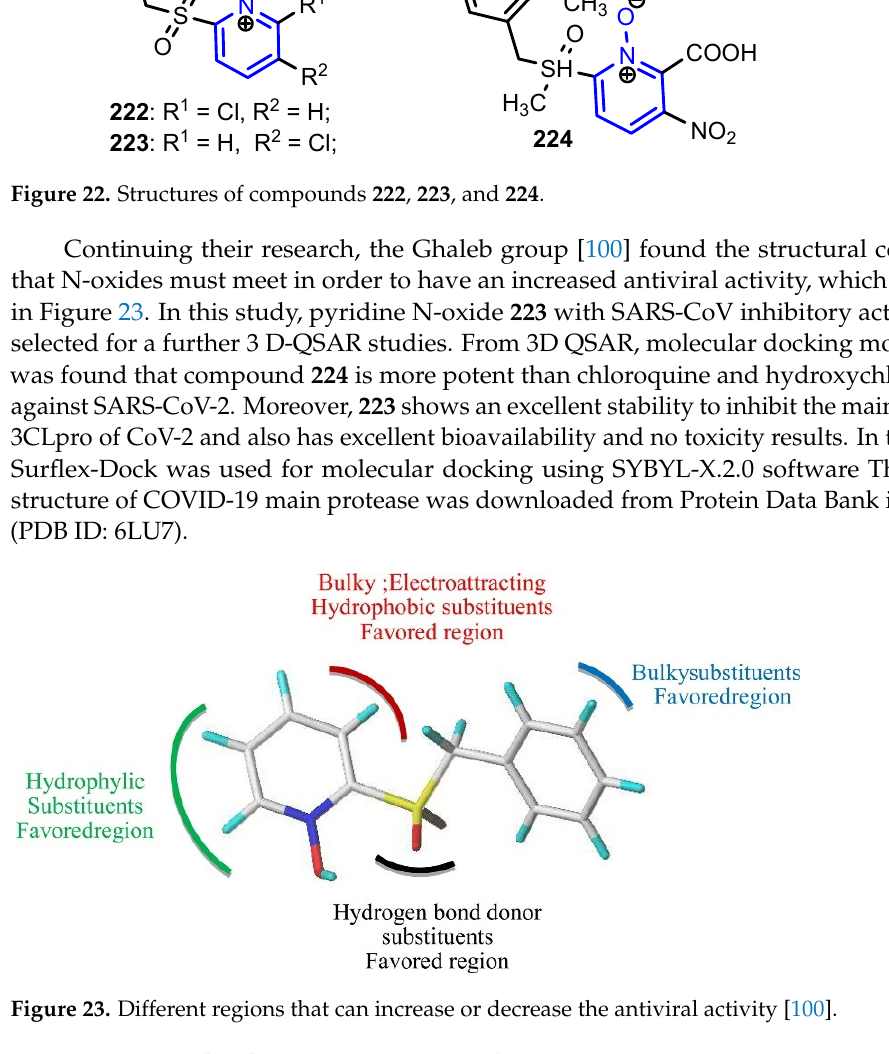
Figure 23. Different regions that can increase or decrease the antiviral activity [100]. Ghosh et al. [101] reported synthesis of 5-chloro-4-methylpyridin-3-yl-1 H -indole- 4- carboxylate 227 from 5-chloro-4-methylpyridin-3-ol 225 and 1H-indole-4-carboxylic acid 226 in the presence of EDC (1-ethyl-3-carbodiimide hydrochloride) and DMAP (4-dimethyl aminopyridine) using dichloromethane as solvent (Scheme 52). Compound 227 exhibited potent antiviral activity (EC 50 ∼ 2.2 µ M) against SARS-CoV-2 3CLpro, which was compara- ble to antiviral medicine Remdesivir. The authors demonstrate that the antiviral activity of a compound is not because of misleading cytostatic effects or cytotoxic effects but due to an apparent destructive “antiviral effect.” The determined high-resolution X-ray structures of compounds bound to SARS-CoV 3CLpro and SARS-CoV-2 3CLpro enzymes revealed that catalytic Cys145 formed a covalent bond with the indole carbonyl group. Furthermore, the indole rings of the inhibitor formed π − π stacking interactions with the imidazole ring of His41, a residue that must move substantially before, during, and after reaction with the inhibitors (Figure 24). X-ray data of the compounds were indexed, integrated, and scaled using the HKL2000 software package.